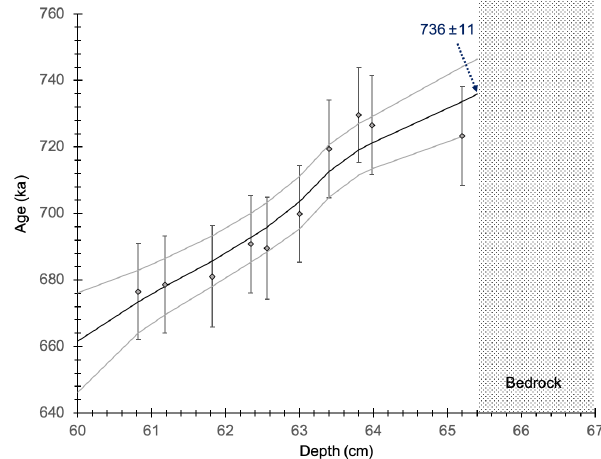
Figure 7. OxCal-derived age model (black line), 95% confidence limits (grey lines), and 234 U ages (diamonds) with 2 σ uncertainties for the lowest 17cm of the core. The time series indicates that the initiation of calcite growth in DH2 occurred at 736 ±